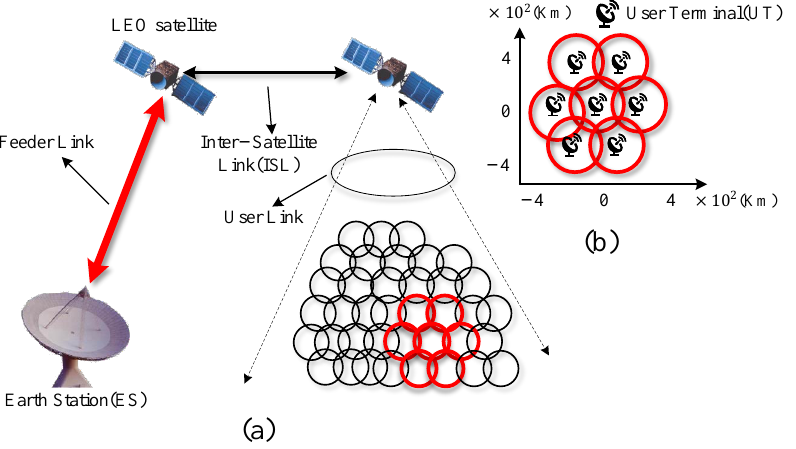
Figure 1. ( a ) Geometrical representation of a LEO satellites network system. ( b ) Schematic diagram of beam